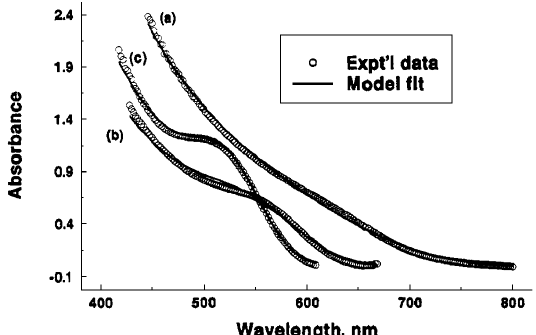
Fig. 4 Experimental absorption spectra (circles) for InP QD colloids with fit to model shown as a solid line: (a) fit made to yield the dependence of QD band gap on QD size; (b and c) fit made to yield the size distribution from the results of (a). Reprinted with permission from Mićić et al., “Synthesis and Characterization of InP Quantum Dots” J. Phys. Chem. 1994 98(19), p. 4966– 4969. Copyright 1994 American Chemical